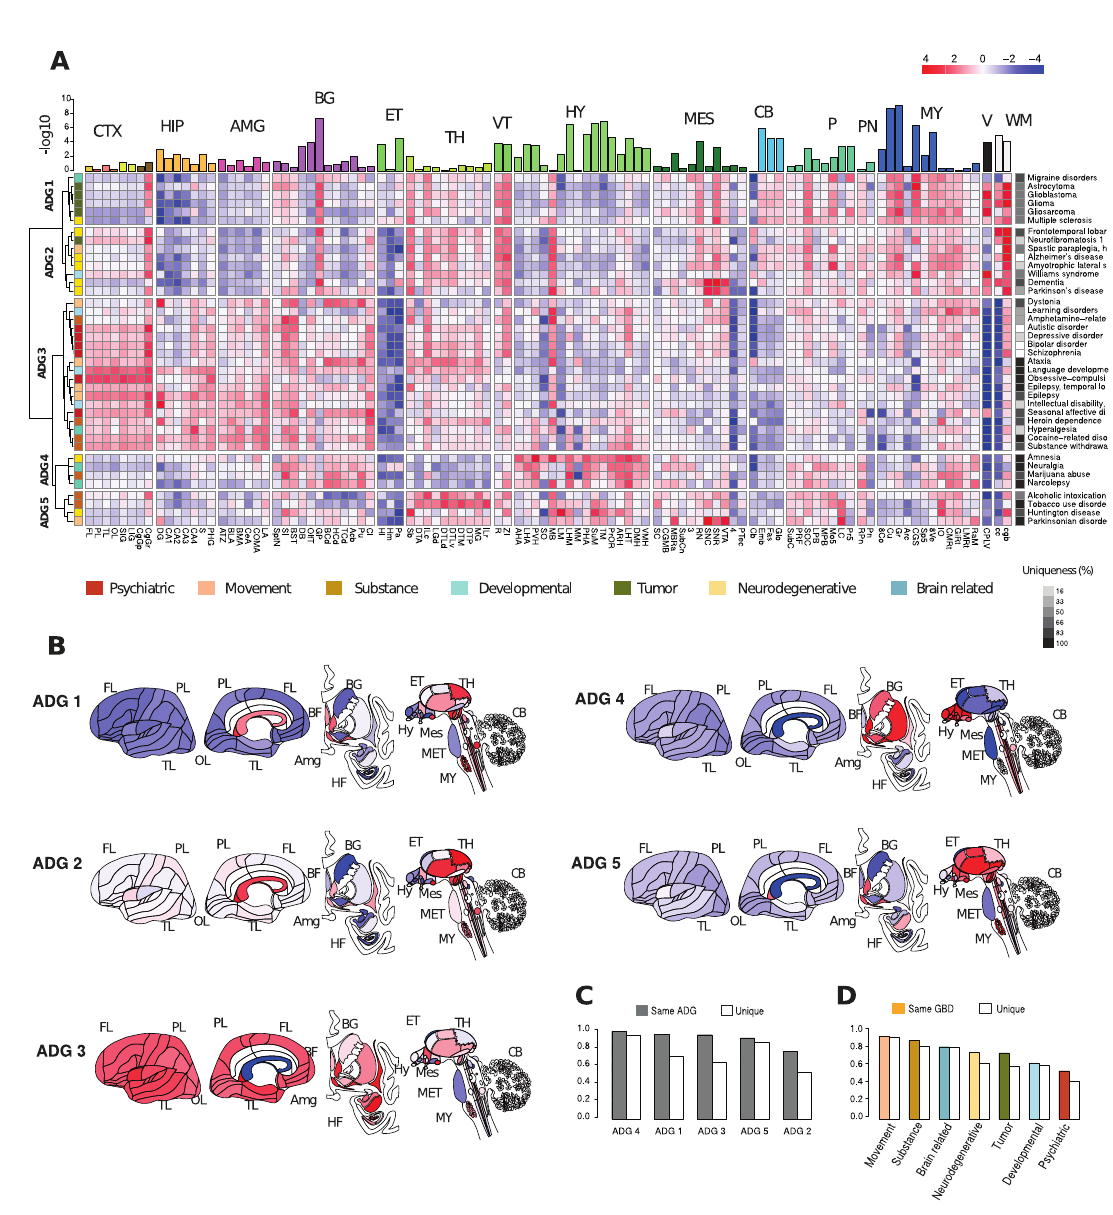
Fig 1. Transcriptome patterning of major brain diseases. AU : AbbreviationlistshavebeencompiledforthoseusedinFigs 1 to 5 : Pleaseverifythatallentriesarecorrect : (A) Mean gene expression profiles for genes associated with 40 major brain diseases and disorders profiled over 104 anatomic structures ( S3 Table ) from 15 major regions cortex (CTX), hippocampus (HIP), amygdala (AMG), basal ganglia (BG), epithalamus (ET), thalamus (TH), ventral thalamus (VT), hypothalamus (HY), mesencephalon (MES), cerebellum (CB), pons (P), pontine nuclei (PN), myelencephalon (MY), ventricles (V), white matter (WM). Hierarchical clustering based on z-score mean profile yields 5 primary anatomic disease groups ADG 1 – ADG 5 . Row annotation (left bar) shows phenotypic GBD membership with color codes. Column bar annotation is 5 group ANOVA for ADG expression variability at a fixed structure. Row annotation (right bar): number of genes associated with disease (log scale). (B) Brain graphic illustrating anatomic patterning of classes ADG 1–5. (C) Reproducibility of ADG profiles. (Solid) Frequency that an ADG disease transcriptomic signature is most closely correlated with a signature from the same ADG in other subjects. (Open) Frequency that exact disease is identified in other subjects. (D) Similar analysis for diseases by phenotypic GBD groups. (Solid) Same GBD class, (Open) exact disease agreement. Underlying data for Fig 1 can be found in S1 and S2 Tables, and the data from S1 Data HBA disease files. Raw data available at http:// human.brain-map.org/. Code available as a notebook at https://github.com/yasharz/human-brain-disease-transcriptomics. ADG, Anatomic Disease Group; GBD, Global Burden of Disease.